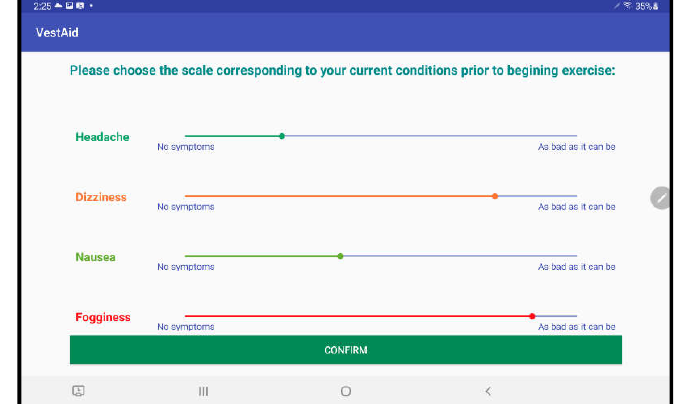
Figure 3. Instructional video page.